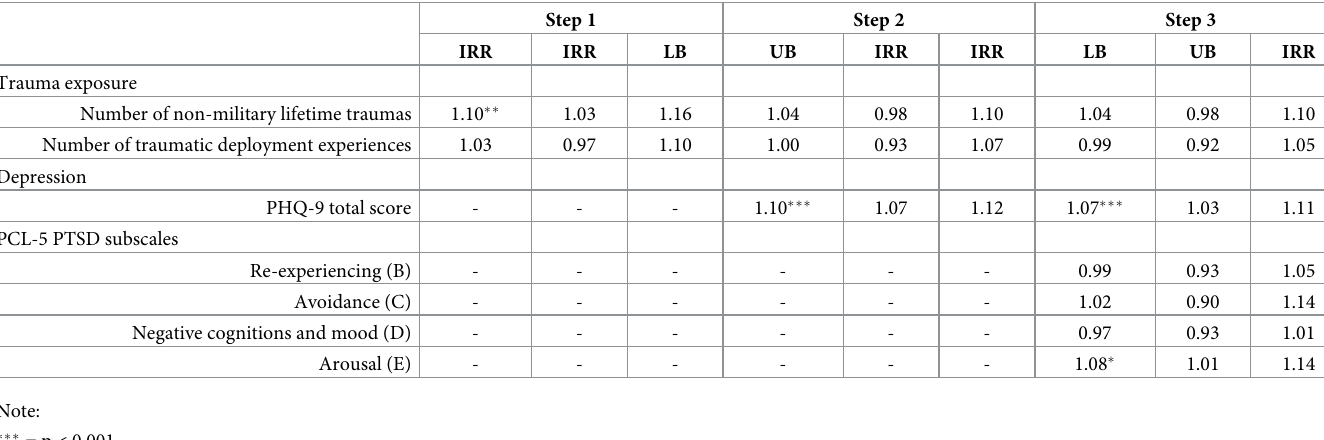
Table 5. Negative binomial regression model predicting gambling total score. Step 1 Step 2 Step